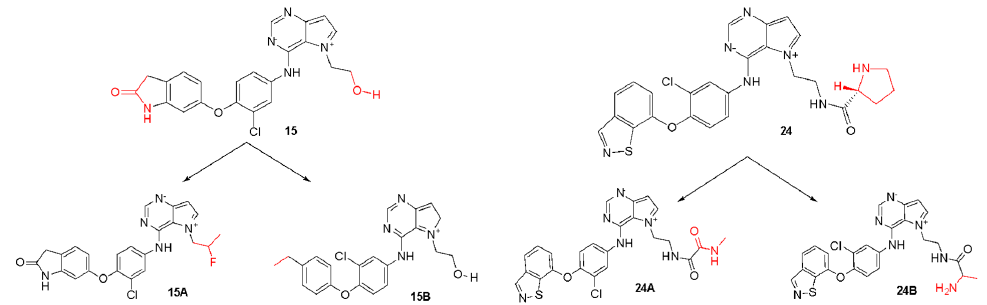
Figure 8. Original chemical structure of the compounds 15 and 24 and the new proposed compounds. (The red regions are groups that were substituted to compose the new molecules). Table 5. New compounds proposed from the 3D models and the predicted pIC 50 values.